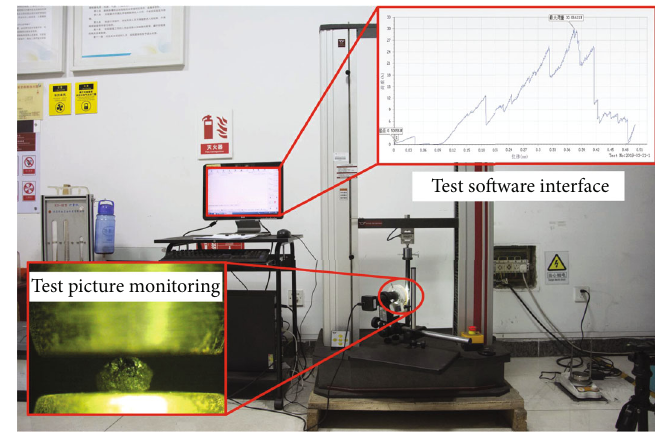
Figure 4: Particle strength test device.